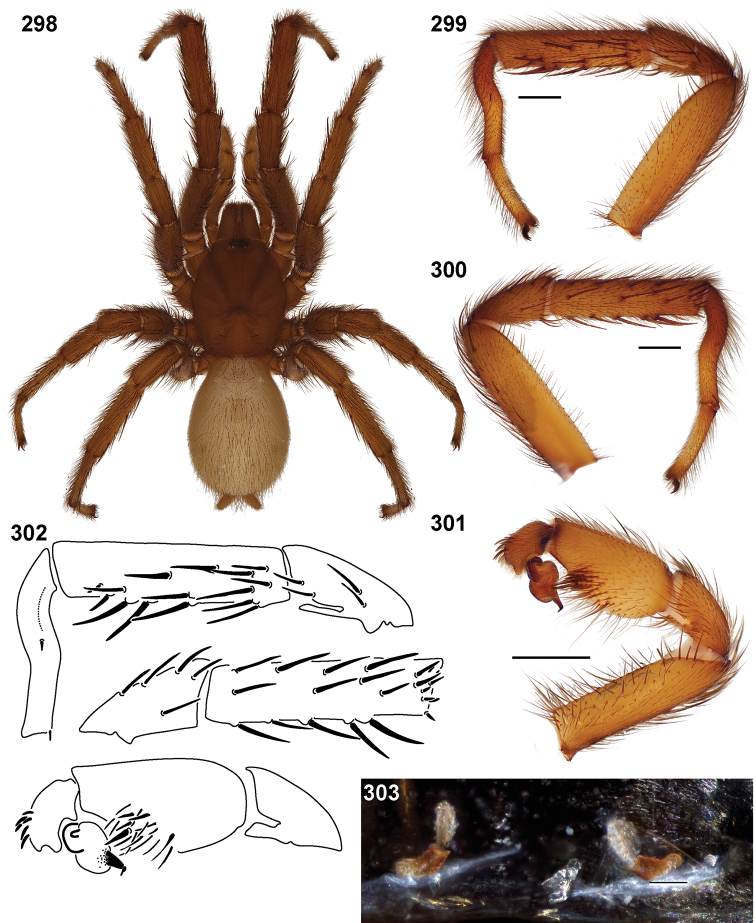
Aptostichus fornax sp. n. 298–302 male holotype (AP418) from Inyo County; scale bars = 1.0mm 298 habitus [806456] 299 retrolateral aspect, leg I [806460] 300 prolateral aspect, leg I [806462] 301 retrolateral aspect, pedipalp [806464] 302 line drawings of leg I spination pattern and pedipalp; retrolateral aspect patella, tibia, metatarsus; prolateral aspect patella and tibia; retrolateral aspect, pedipalp 303 female paratype (AP578), cleared spermathecae [806465]; scale bar = 0.1mm.